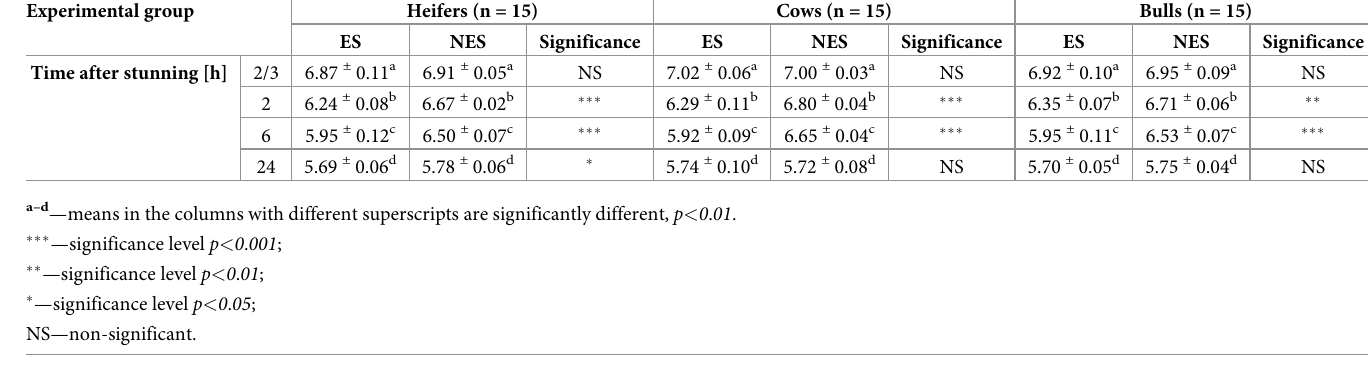
Table 4. Changes in the pH value ( � x ± SD) of the longissimus dorsi muscle of non-electrostimulated (NES) and electrostimulated (ES) heifers (H), cows (C), and bulls (B) chilled with the fast method. Experimental